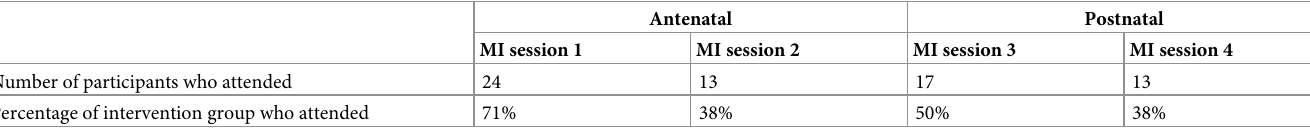
Table 5. Number of participants attending each MI